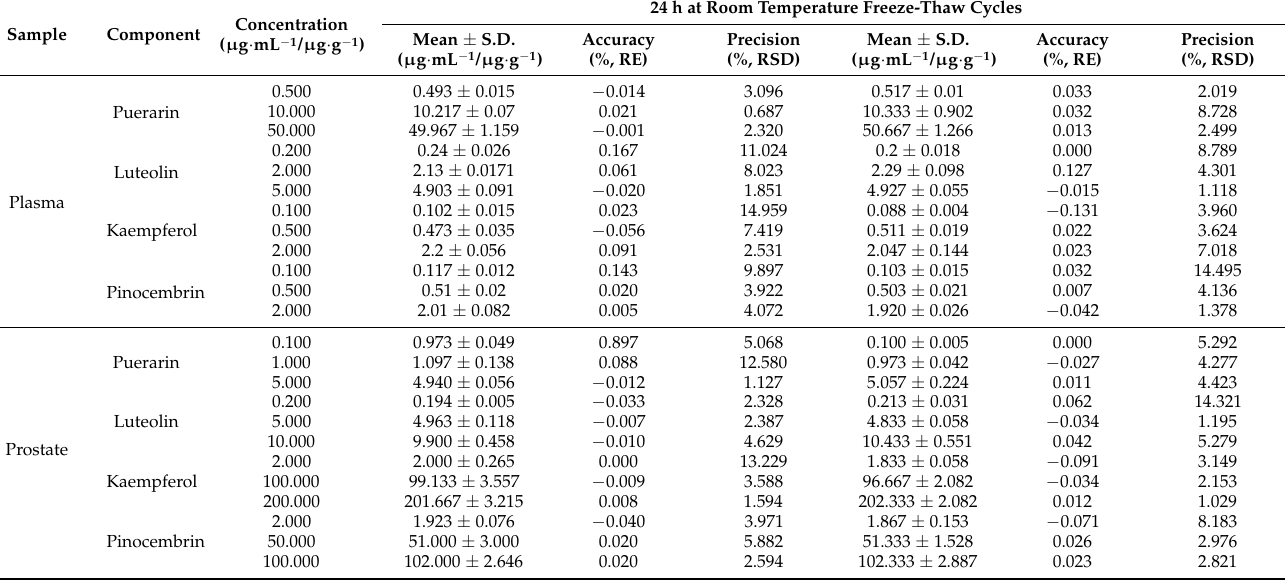
Table 6. Stability test of four analytes in plasma and prostate ( n =